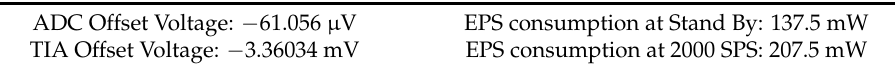
Table 11. Additional features of the EPS with a source voltage of 5 volts.